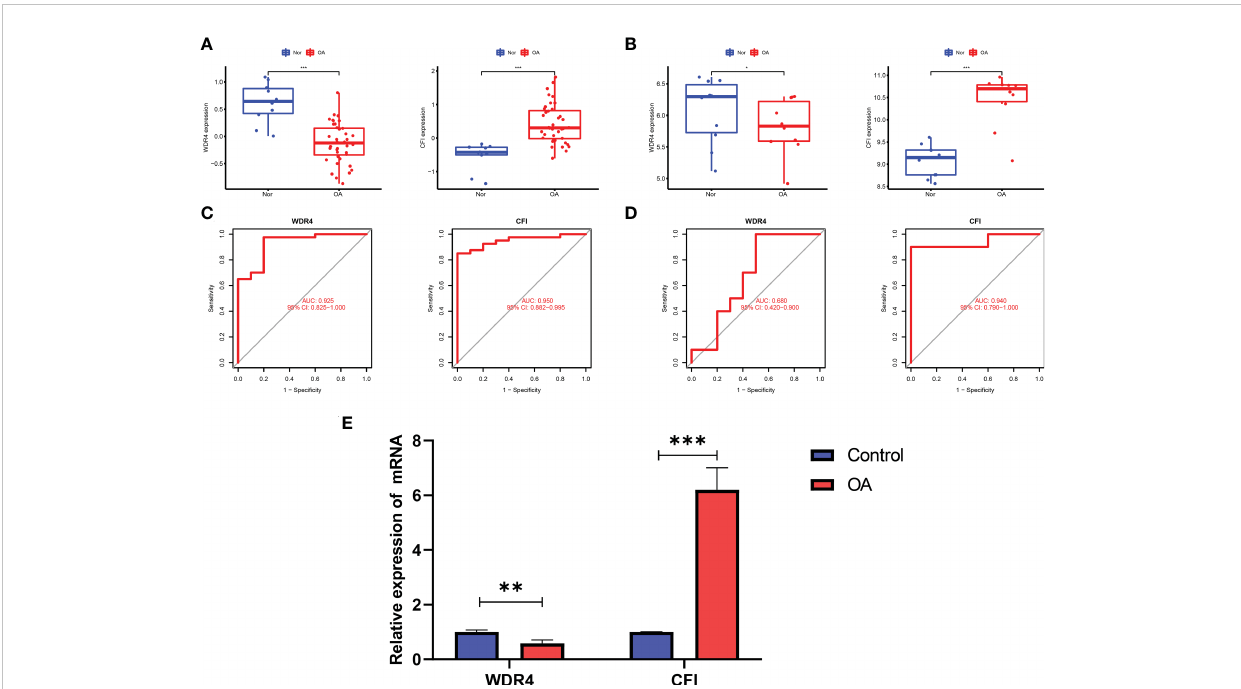
FIGURE 3 Validation of hub genes in the gene expression level and diagnostic value. (A) Validation of hub genes in the GSE51588. CFI were signi fi cantly more highly expressed in OA compared with healthy controls, while WDR4 was signi fi cantly lower expressed in OA tissues compared with healthy controls. (B) Validation of hub genes in the GSE55457 and the results were the same as the results of the GSE51588. (C) Validation of hub genes in the GSE51588. ROC curves and AUC statistics are used to evaluate the capacity to discriminate OA from healthy controls with excellent sensitivity and speci fi city. (D) Validation of hub genes in the GSE55457 and the results were similar to the results obtained from GSE51588. (E) The relative mRNA expression of WDR4 and CFI were displayed. For all fi gures: * represents p <0.05, ** represents p <0.01 and *** represents p <0.001. OA, osteoarthritis; ROC, receiver operating characteristic; AUC, area under the